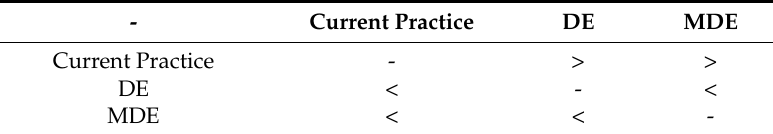
Table 15. The statistical result of the proposed